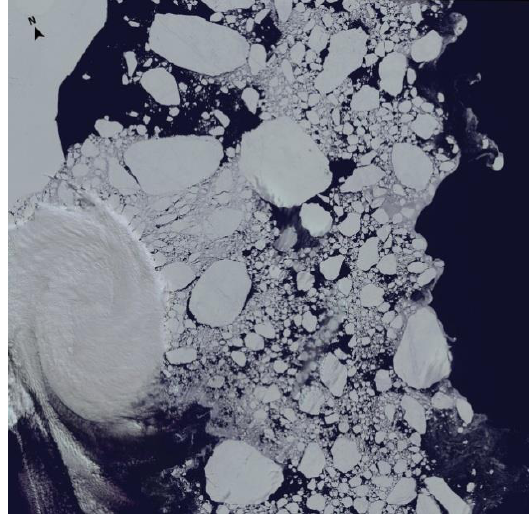
Fig 2 Image of the Ross Archipelago near the McMurdo Station in Antarctica